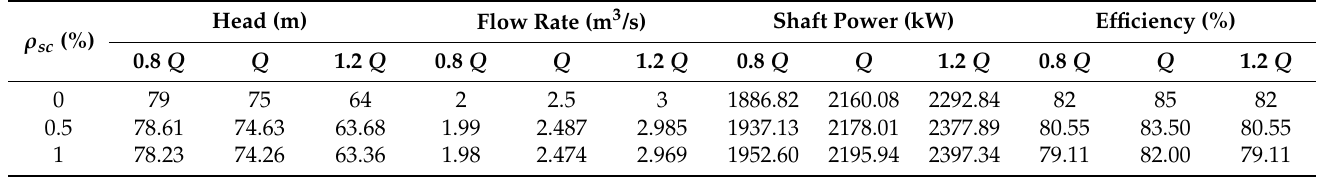
Table 8. Calculation results of fitting equations for sediment concentrations of 0%, 0.5%, and 1%.